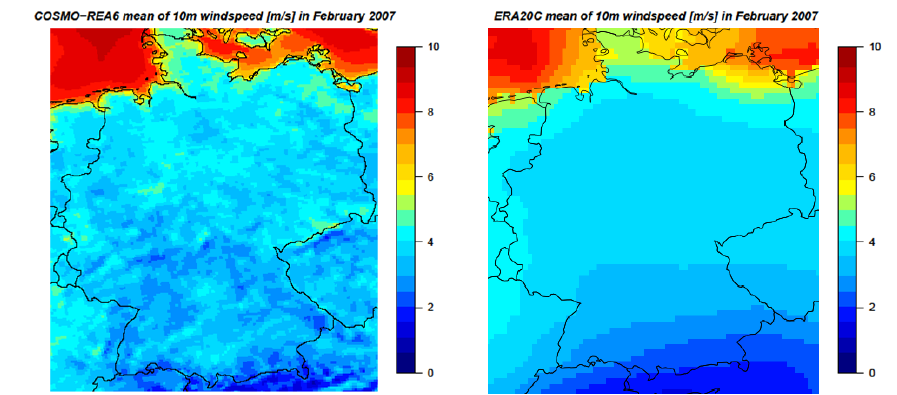
Figure 2. 10m surface winds from the COSMO-REA6 regional reanalysis (left) and the ERA-20C interpolated wind fields (right) illustrate the different spatial resolution for the month of February 2007.